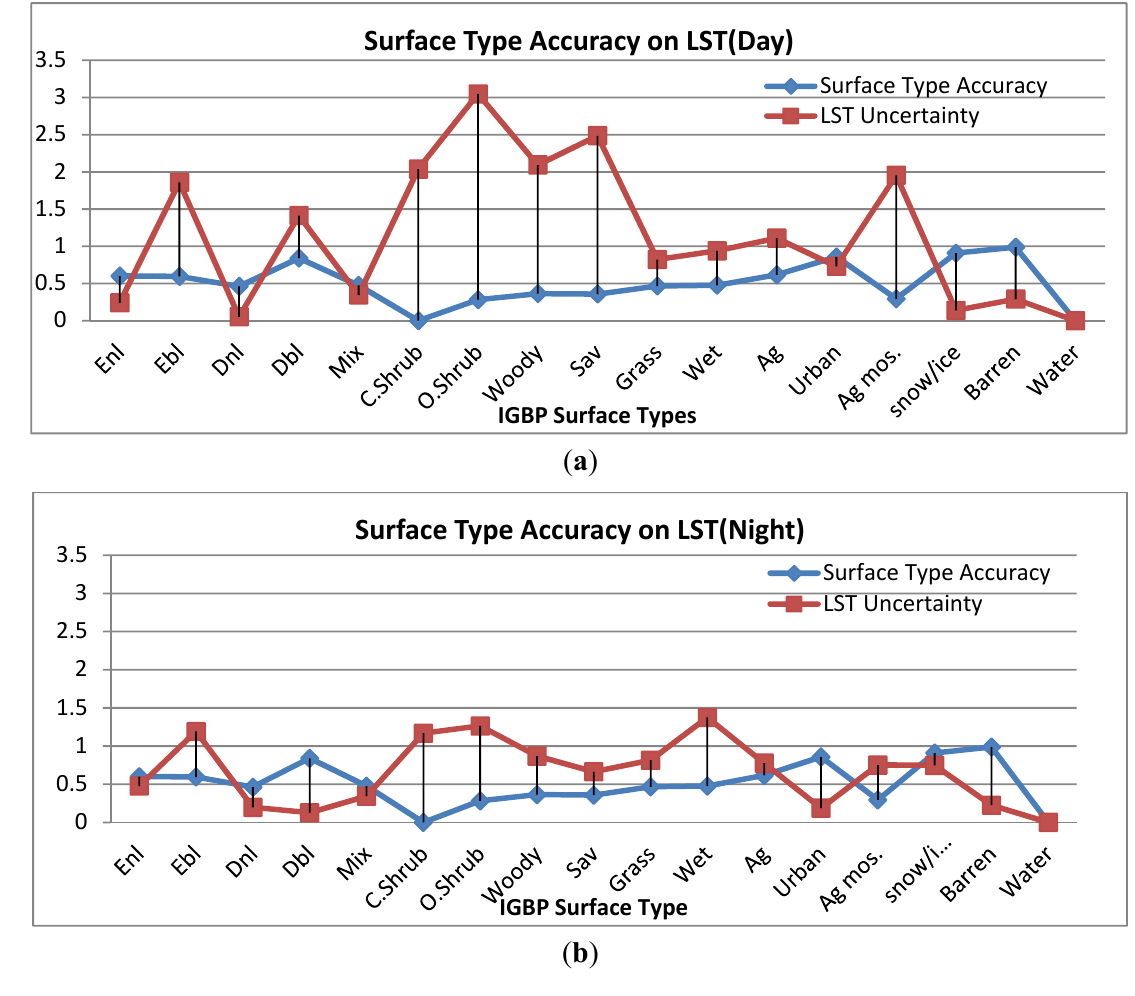
Figure 9. Impact of surface type accuracy (blue line, ranging from 0 to 1) on LST uncertainty (red line, in K) for daytime ( a ) and nighttime ( b )